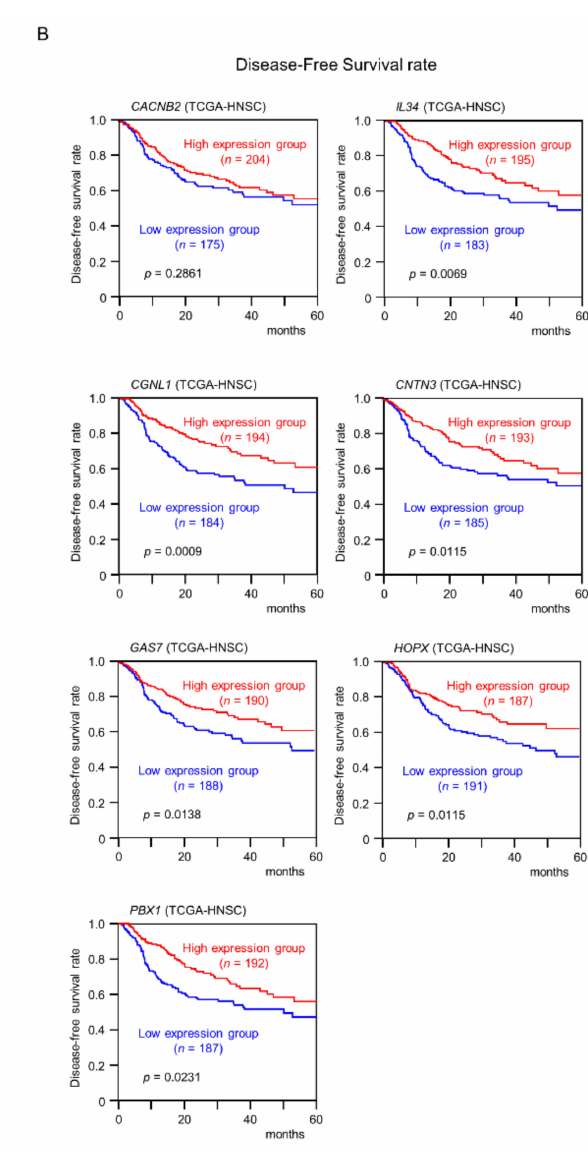
Figure 5. Clinical significance of seven target genes ( CACNB2, IL34, CGNL1, CNTN3, GAS7, HOPX, and PBX1 ) according to TCGA-HNSC data analysis. ( A ) Kaplan–Meier curves of the 5-year overall survival rate according to the expression of each gene are presented. Low expression of all seven genes was significantly predictive of a worse prognosis in patients with HNSCC. Patients were divided into two groups according to the median miRNA expression level: high and low expression groups. The red and blue lines represent the high and low expression groups, respectively. ( B ) Kaplan–Meier curves of the 5-year disease free survival rate according to the expression of each gene are presented. Low expression of six genes other than CACNB2 was significantly predictive of a worse prognosis in patients with